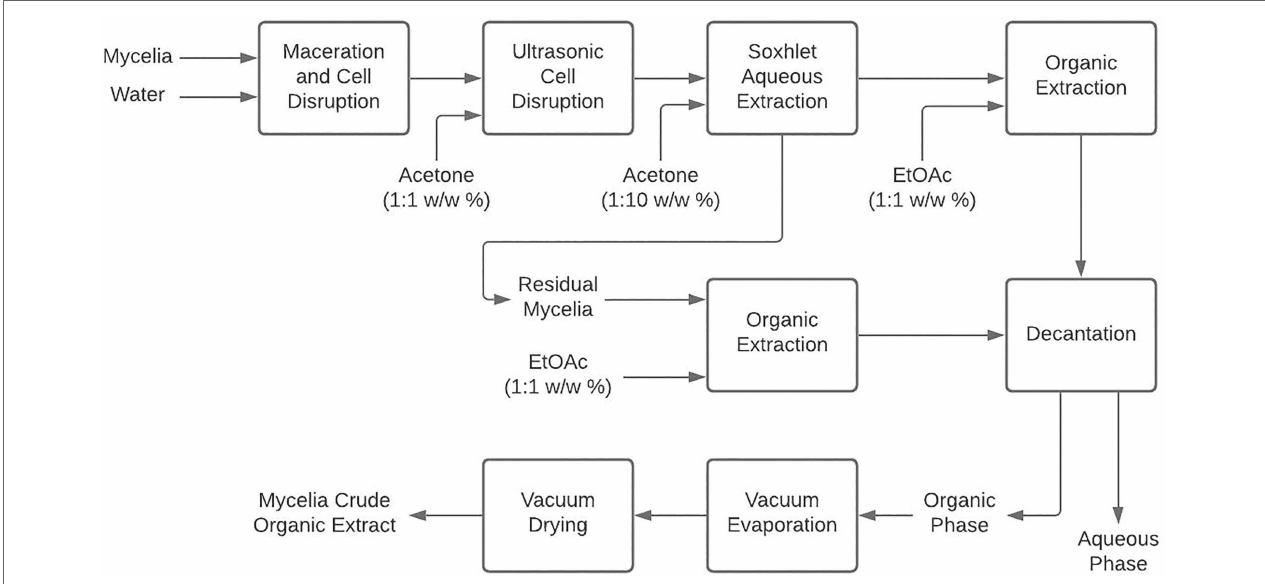
FIGURE 1 | Mycelium extraction procedure to obtain organic crude extracts from liquid cultivation of endophytic